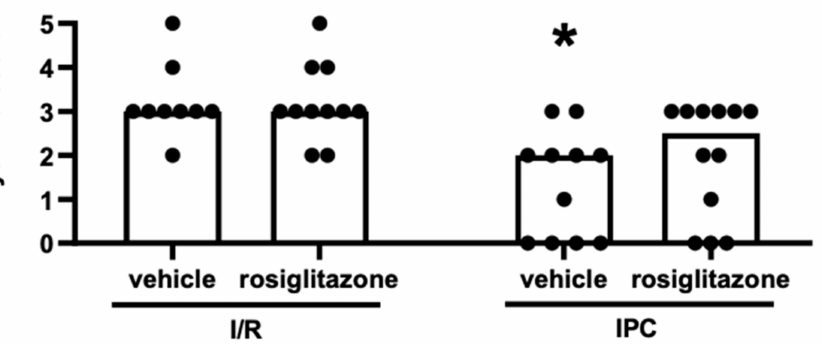
Figure 3. Arrhythmia scores over the entire duration of the myocardial ischemic period and the first 15 min of reperfusion . Results are presented as median with individual data points. Chronic rosiglitazone treatment does not increase the arrhythmia score during ischemia/reperfusion but abolishes the antiarrhythmic effect of ischemic preconditioning. (Kruskal–Wallis, Dunn’s post hoc, * p < 0.05 vs. I/R + vehicle, n = 11–12) IPC : ischemic preconditioning; I/R :